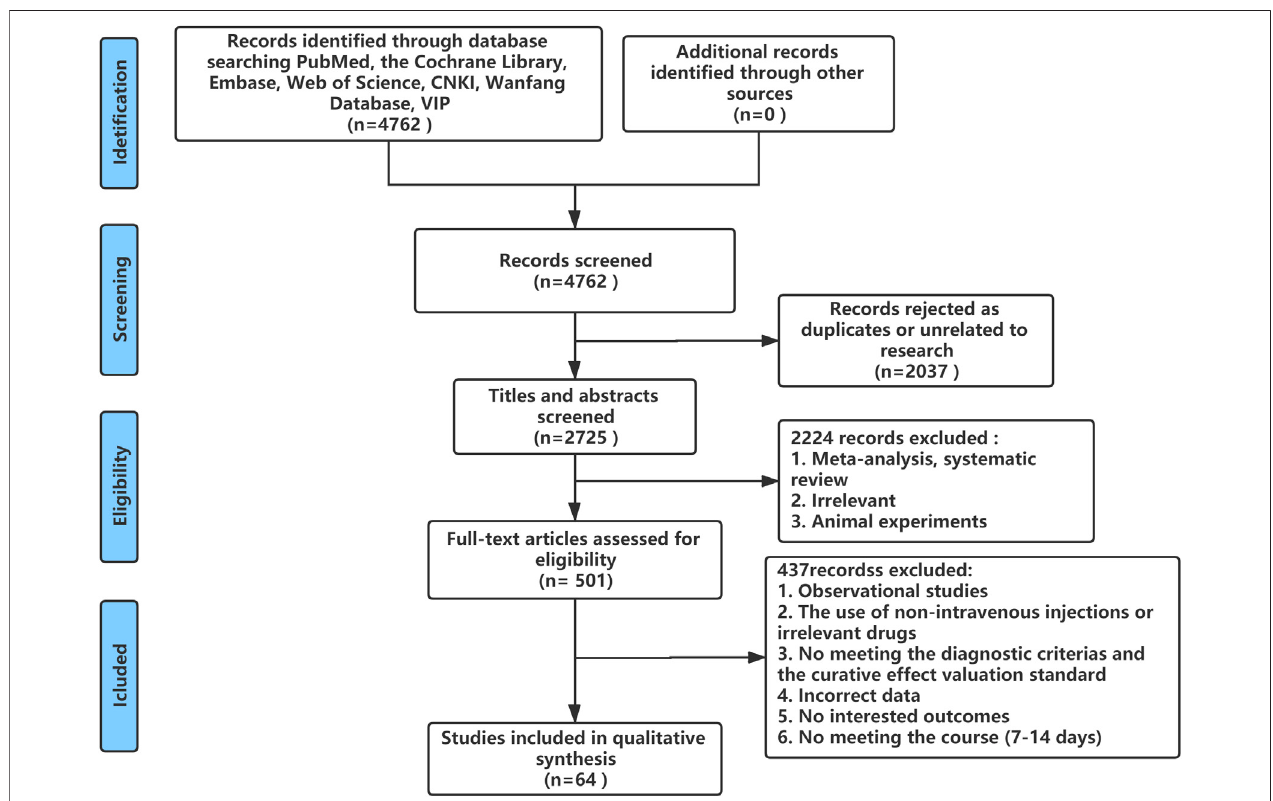
FIGURE 1 | Flow diagram of study